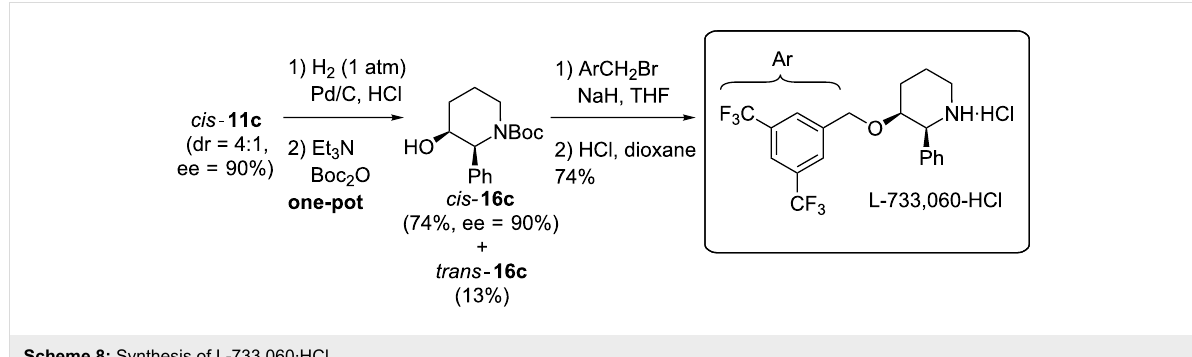
Scheme 8: Synthesis of